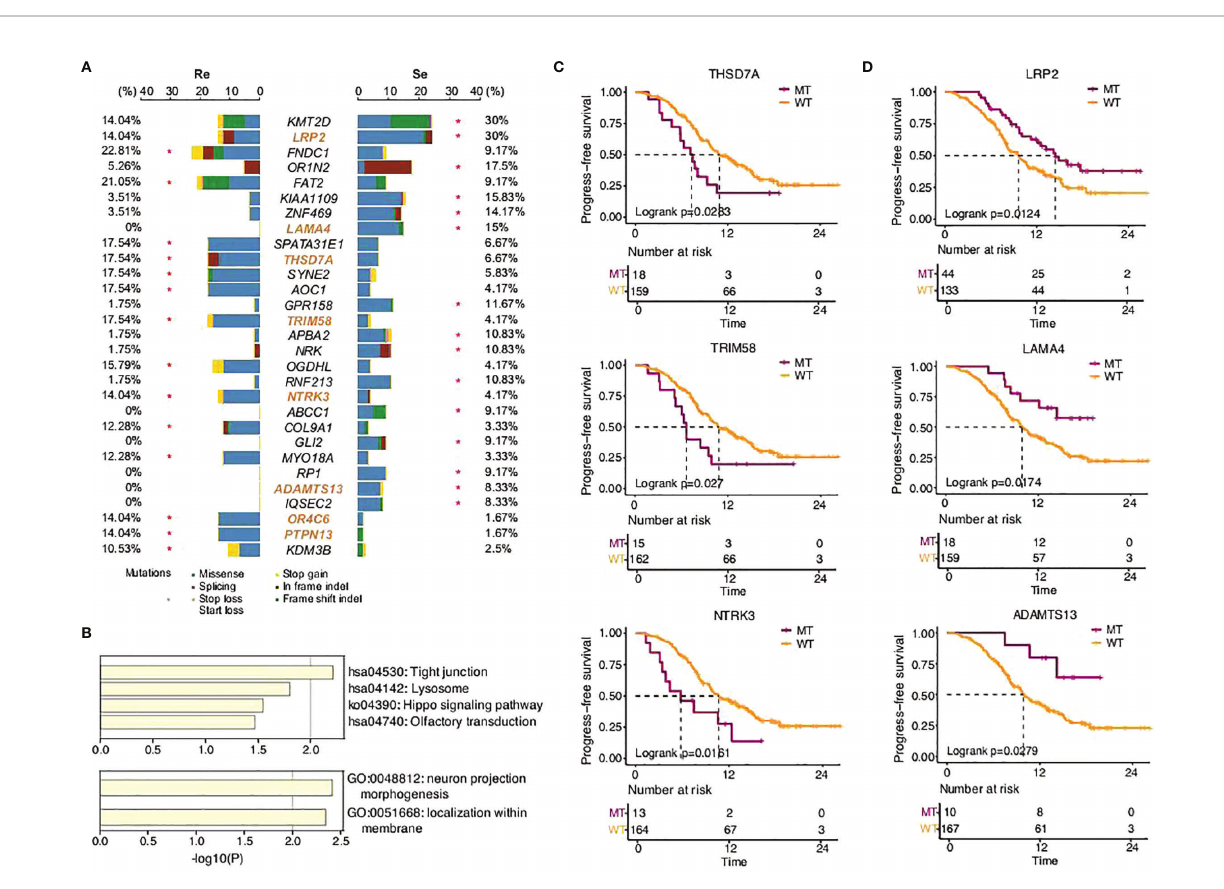
FIGURE 2 | SCLC patients ’ somatic mutational features in the two groups. (A) Comparison of somatic mutational features with a mutation frequency greater than 5%. (B) GO functions enriched by all the genes predicted in this study. KEGG pathways enriched by the somatic mutation genes that signi fi cantly affected PFS time in this study. (C,D) Progression-free survival of different gene status.